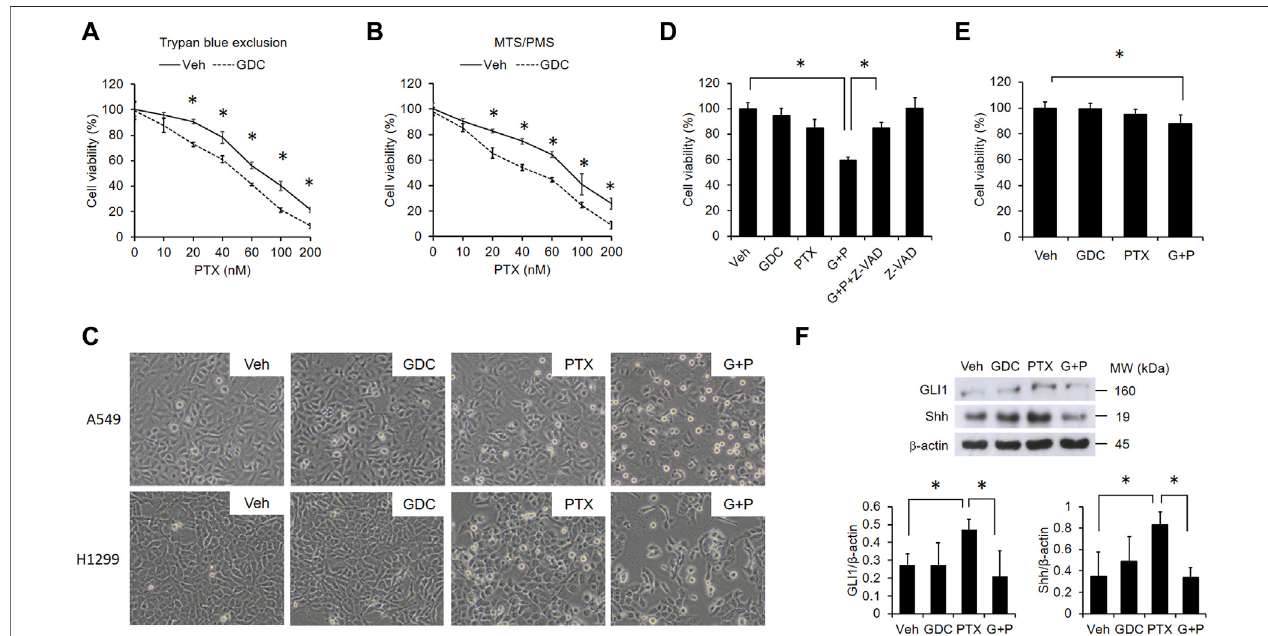
FIGURE 2 | GDC potentiates paclitaxel-induced cytotoxicity in NSCLC cells. A549 cells were preincubated with DMSO (vehicle; Veh) or GDC-0449 (GDC; 20 μ M) for 1 h followed by treatment with various doses of PTX for 24 h. Cell viability was determined by trypan blue exclusion (A) and MTS/PMS activity (B) assays. (C) Cells were preincubated with Veh or GDC (20 μ M) for 1 h followed by PTX (20 nM) treatment for 24 h. Apoptotic cells were identi fi ed by morphology under light microscopy (×20objective).G+P,GDC+PTX. (D) CellsweretreatedwithGDC(20 μ M)andPTX(20 nM)for24 h,withorwithoutpreincubationwiththepan-caspaseinhibitor, Z-VAD-FMK(Z-VAD;100 μ M).G+P,GDC+PTX;G+P+Z-VAD,GDC+PTX+Z-VAD.CellviabilitywasanalyzedbytheMTS/PMSactivityassay. (E) MRC-5cellswere preincubated with Veh or GDC (20 μ M) for 1 h followed by PTX (20 nM) treatment for 24 h. Cell viability was assessed with the MTS/PMS assay. (F) A549 cells were preincubated with GDC (20 μ M) for 1 h followed by PTX (20 nM) treatment for an additional 1 h. Whole cell lysates were collected and immunoblotted with anti-GLI1, anti-Shh, and anti- β -actin antibodies. Protein band intensities were analyzed using ImageJ. G + P, GDC + PTX. *: p < .05; indicates a statistically signi fi cant difference between indicated groups. All experiments were performed at least three times. n = 3 for all